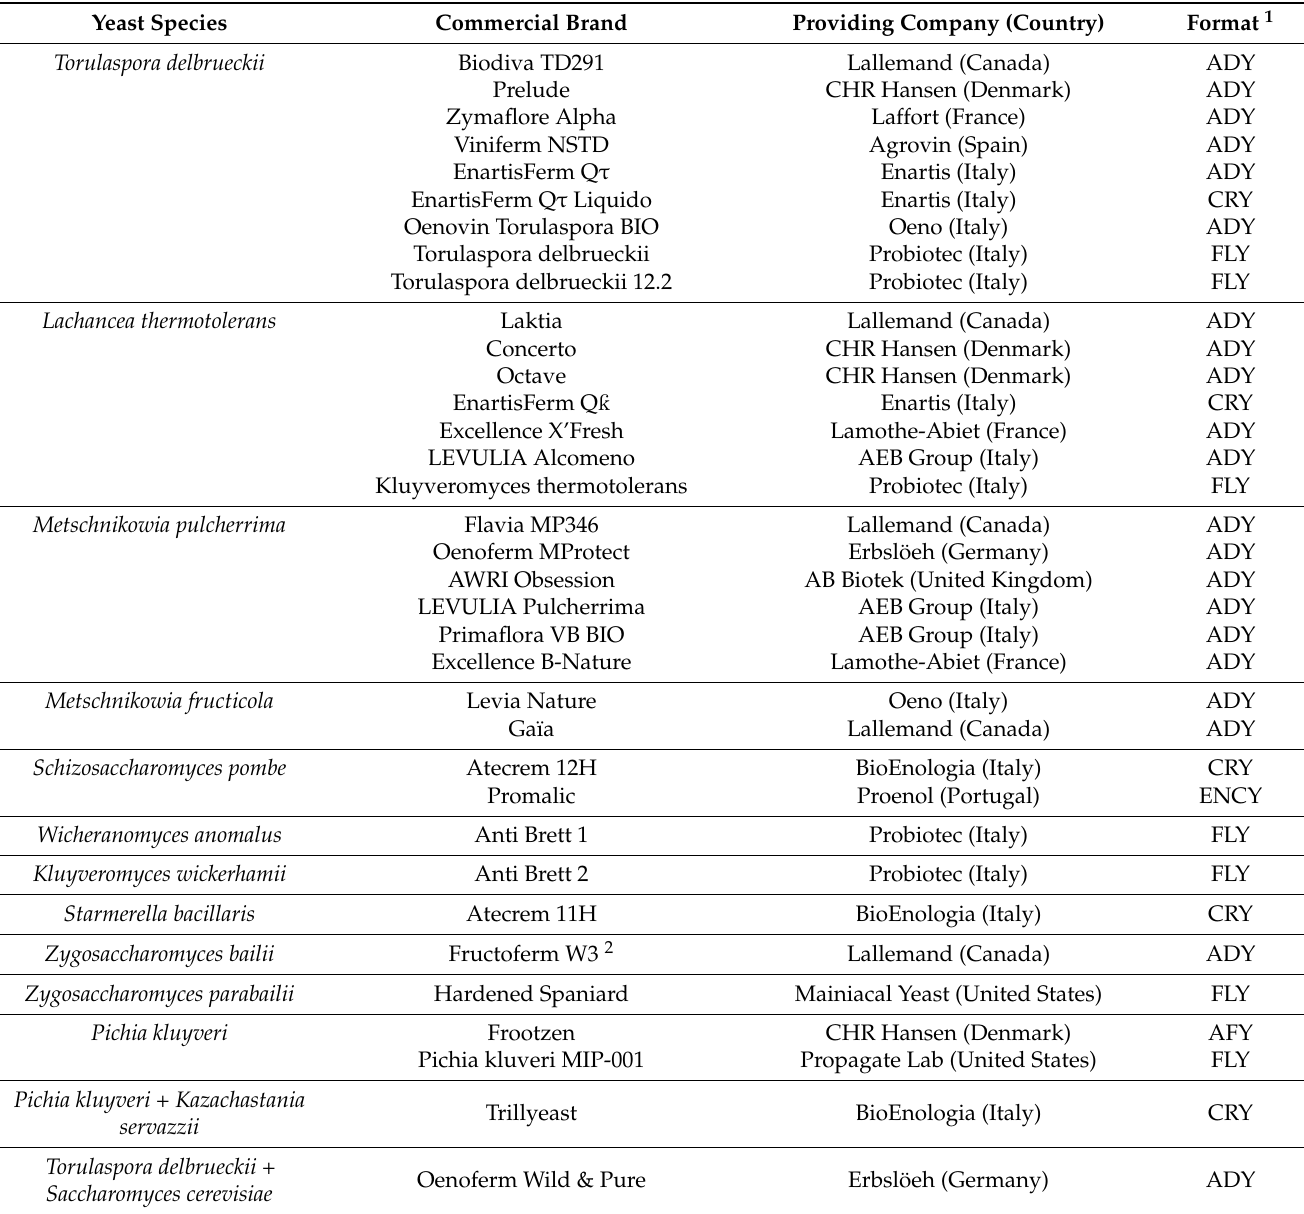
Table 1. Commercial non- Saccharomyces yeasts available on the market. Information obtained from the website of the companies that commercialize them. More details of each yeast are provided in Supplementary Materials (Table S1). Yeast